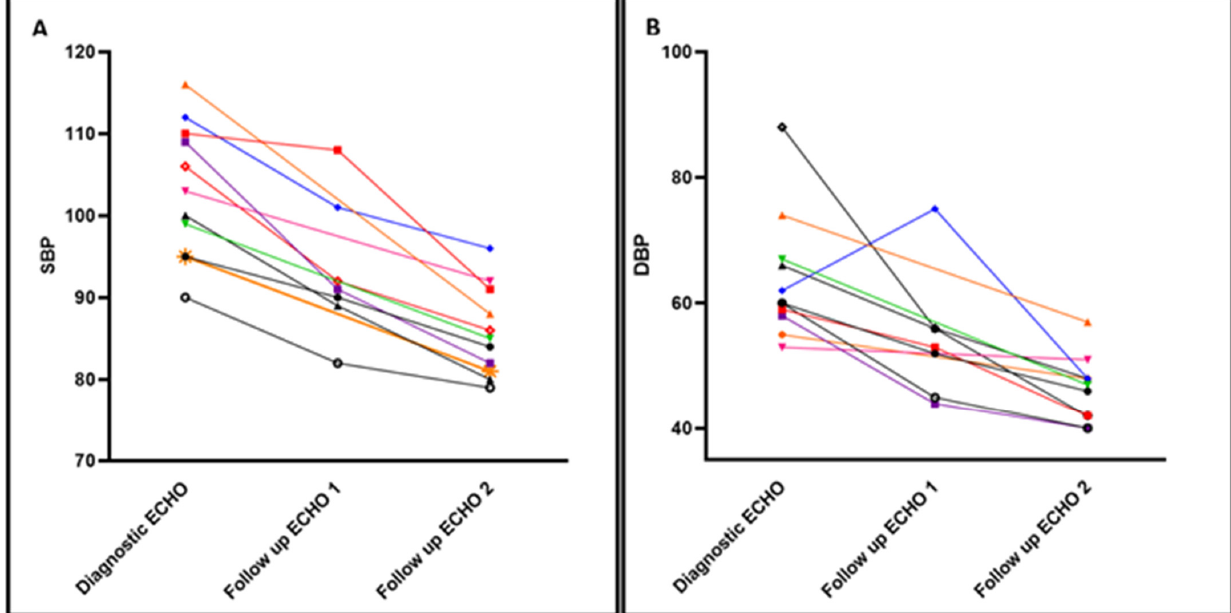
Figure 1. Time-series trends in the Systolic and Diastolic Arterial pressure before/after enalapril. Individual Systolic Blood Pressure (SBP) (Panel A ) and Diastolic Blood Pressure (DBP) (Panel B ) trends at three time points. At time of diagnostic echocardiogram (ECHO), and with two follow up ECHOs. ECHO 1: in average 2 weeks after starting enalapril therapy and, ECHO 2: prior to discharge. Each patient is represented in a different color and vignette. 4 patients did not undergo ECHO assessment at 2 weeks after treatment, and only had one follow up ECHO prior to discharge.